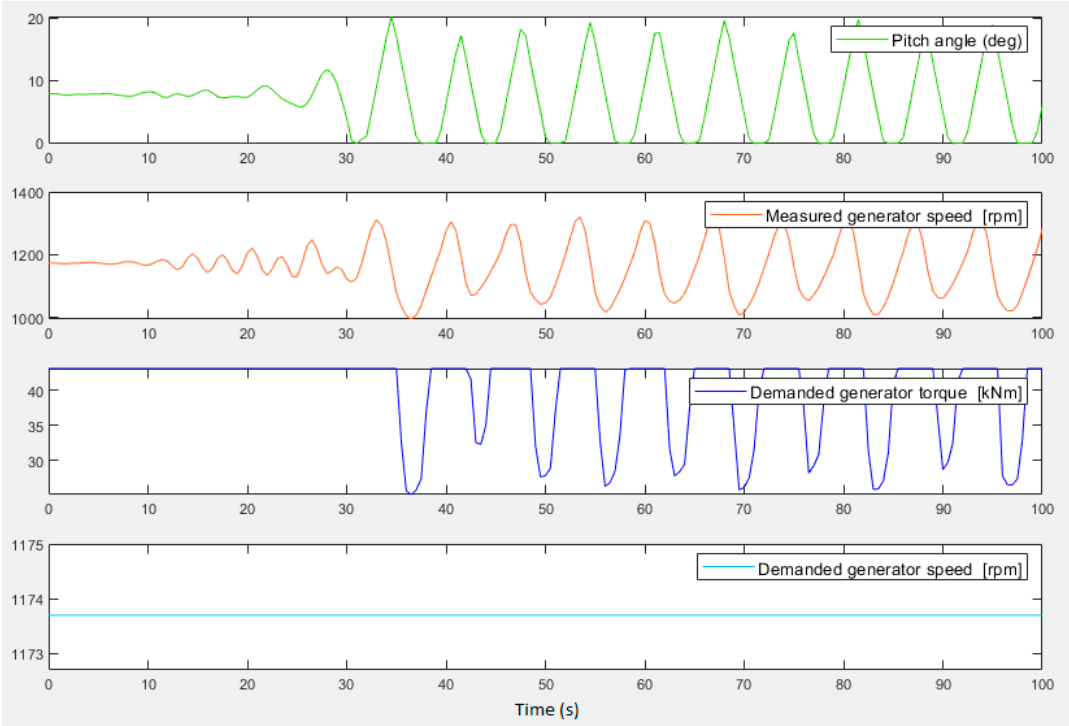
Figure 8. Error in blade’s pitch angle with a built-in controller.